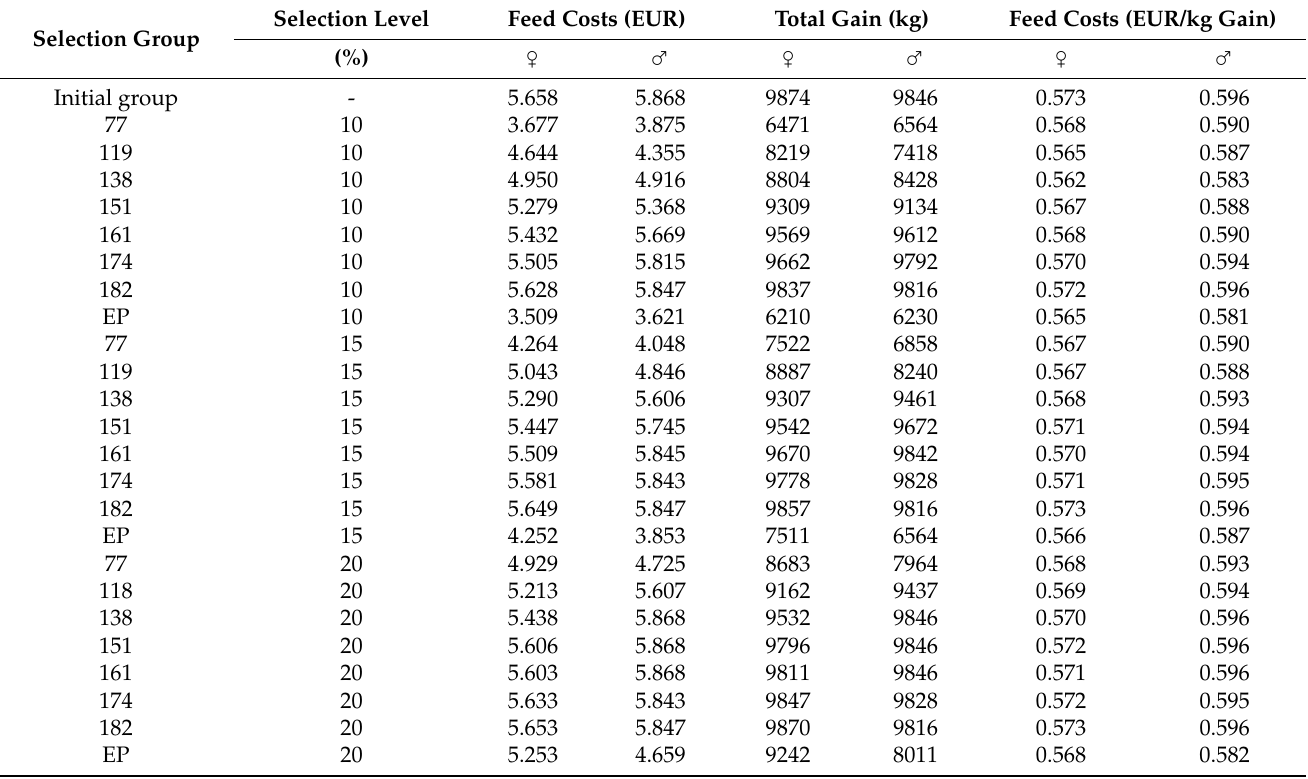
Selection group = group of pigs selected at the time (in days of life); feed costs are based on individual animal data in the selection groups. Feed costs differed between the phases: pre-fattening EUR 0.25/kg, mid-fattening EUR 0.23/kg, finishing EUR 0.21/kg.